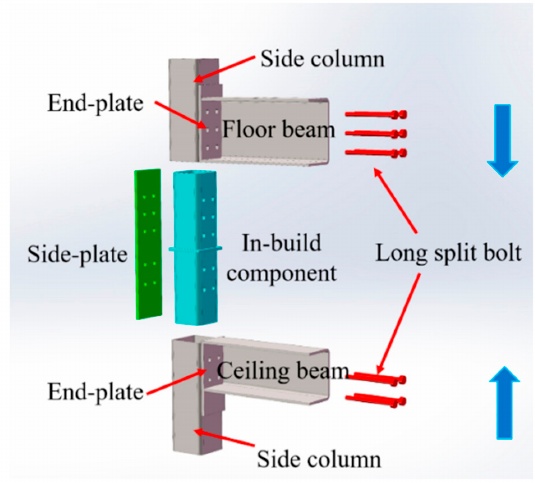
Figure 2. The novel modular connection with inbuild